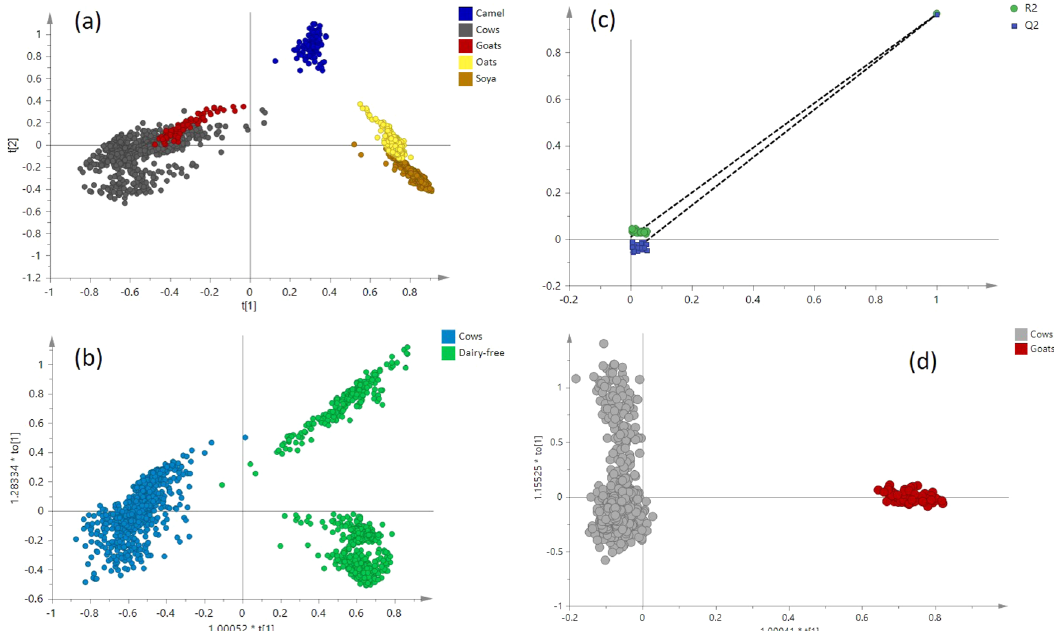
Fig. 4 Differentially component analysis between different milk species. a PCA of fi ve milk species; b OPLS-DA between cow ’ s milk and other milk species; c Permutations plot of OPLS-DA model; d OPLS-DA between cow ’ s milk and goat ’ s